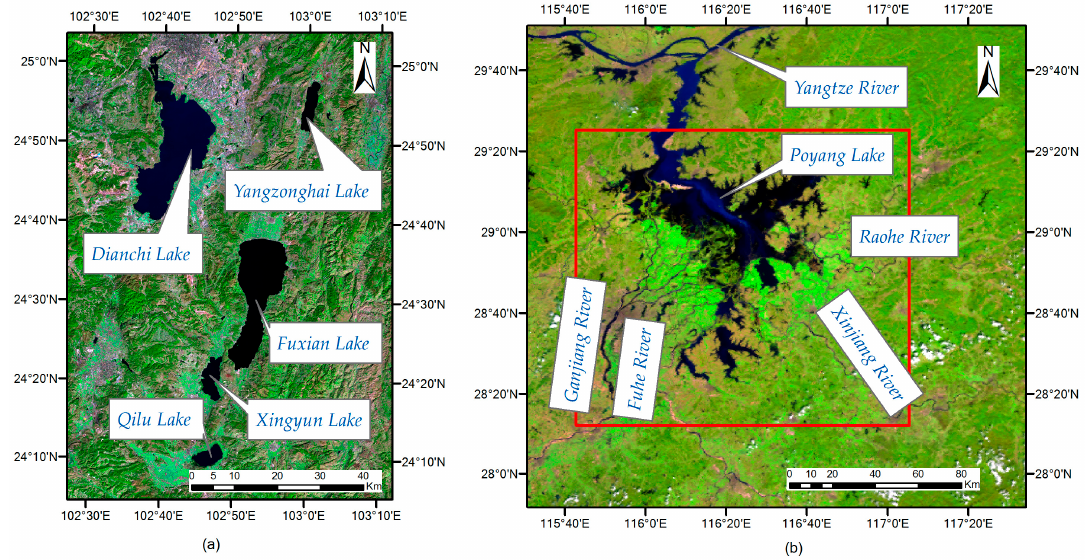
Figure 1. Maps of study areas showing the locations of ( a ) Yunnan lakes, and ( b ) Poyang Lake.